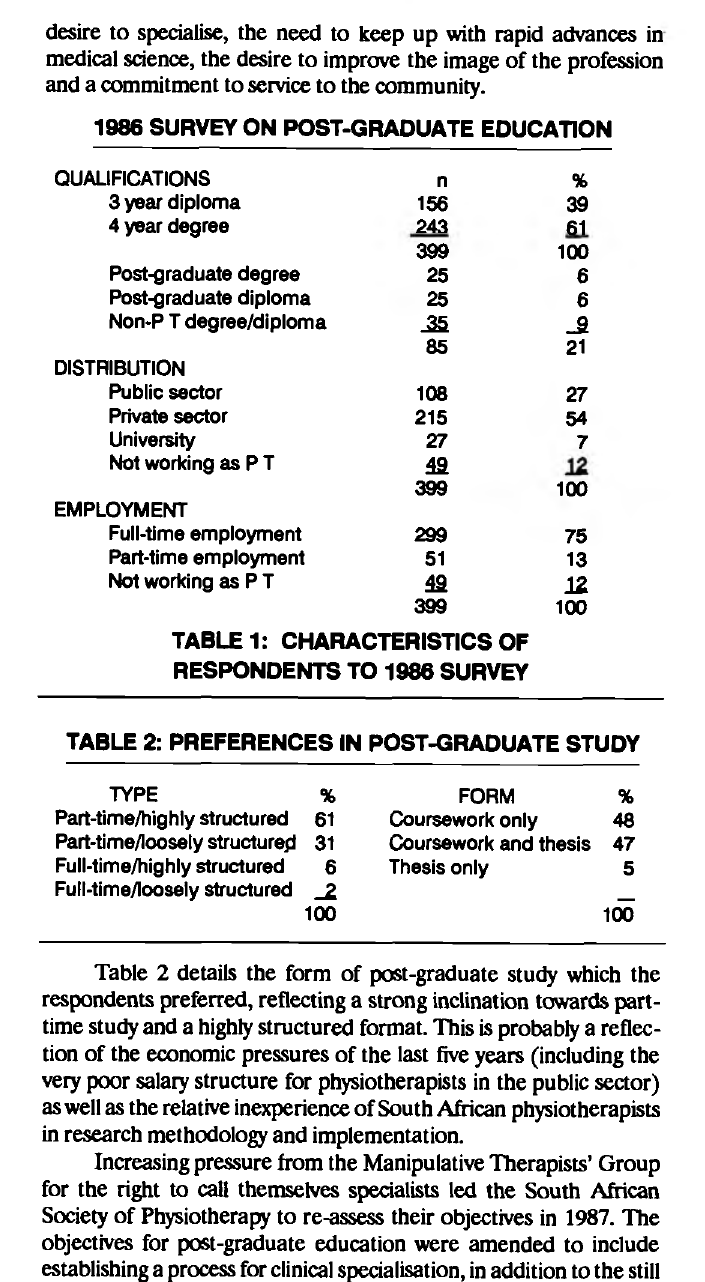
TABLE 4: HONOURS